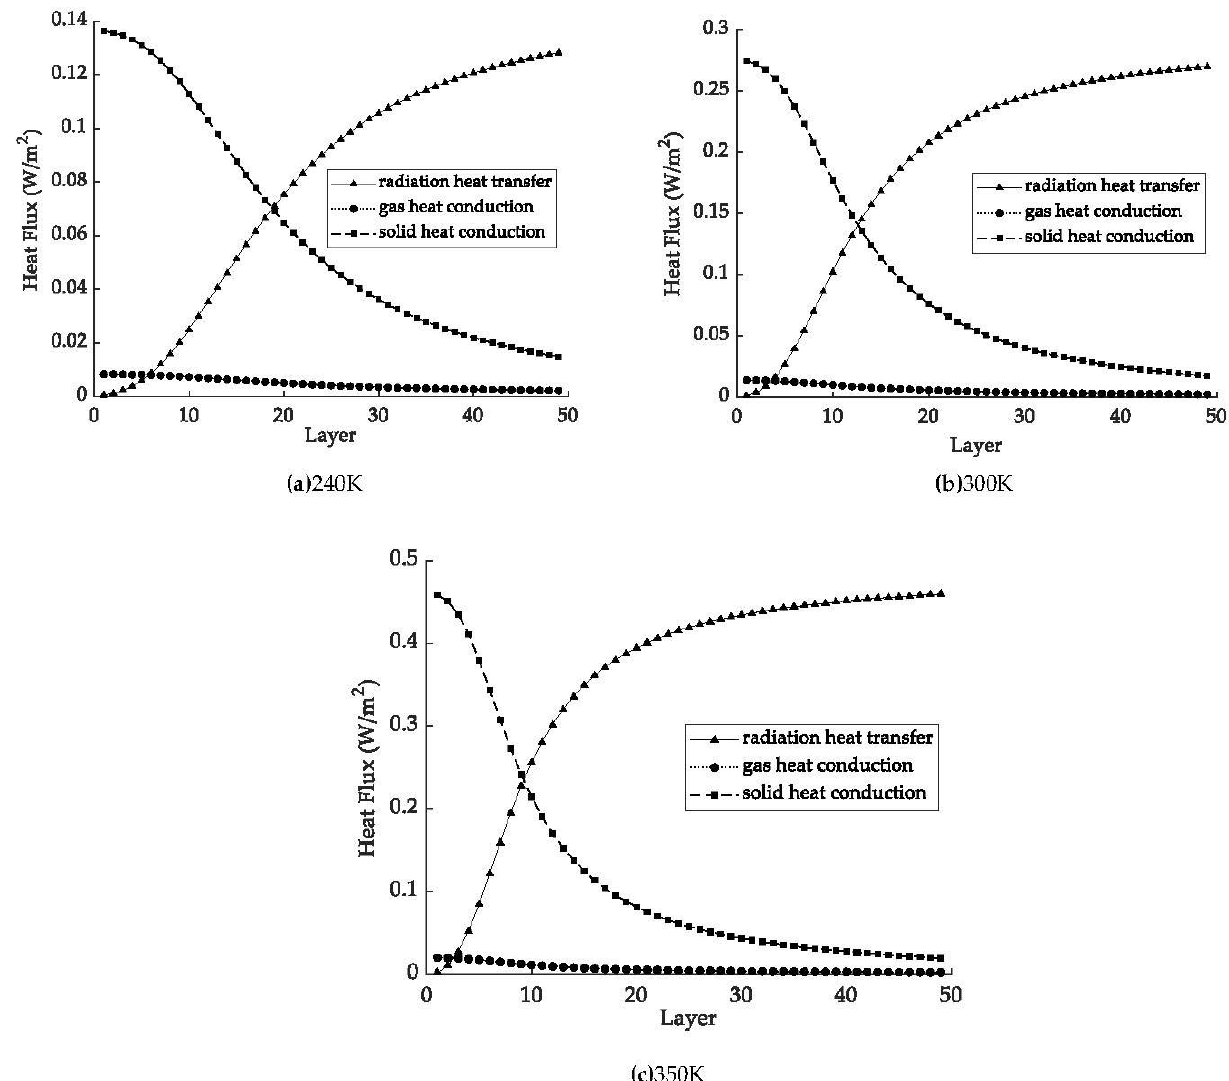
Figure 10. The variation in heat flux with layer position.